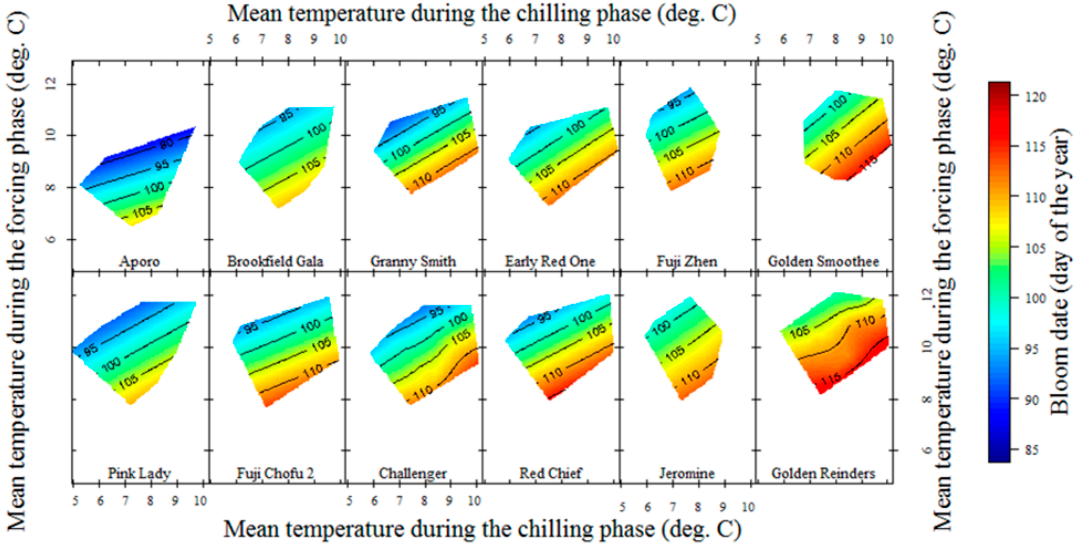
Figure 8. Response of ‘Aporo’, ‘Brookfield Gala’, ‘Granny Smith’, ‘Early Red One’, ‘Fuji Zhen’, ‘Golden Smoothee’, ‘Pink Lady’, ‘Fuji Chofu 2 ′ , ‘Challenger’, ‘Red Chief’, ‘Jeromine’, and ‘Golden Reinders’ blooming dates to mean temperatures during the chilling and forcing phases in Mas Badia for the period 1992–2018. The color spectrum has to be interpreted as variation of the flowering dates. Individual plots can be found in Supplementary Figures S61 to S72.